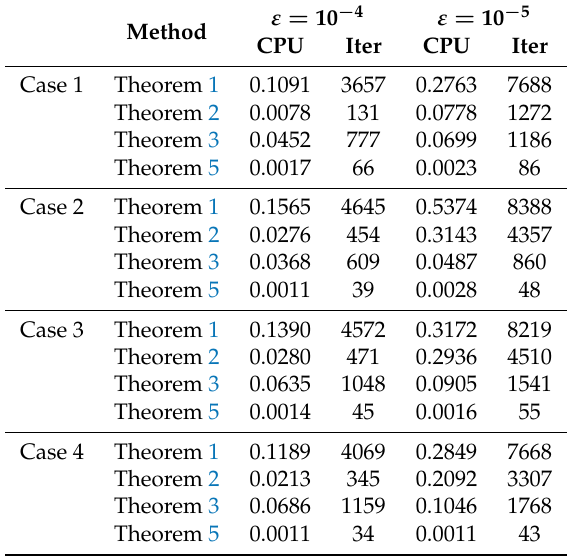
Table 1. Comparison for Theorems 1–3 and 5 for each